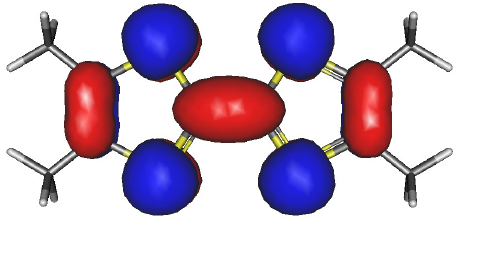
Figure 4. Contour plot for the HOMO orbital of a neutral TMTTF molecule. The charge is mainly located on the sulfur atoms and the three C = C double